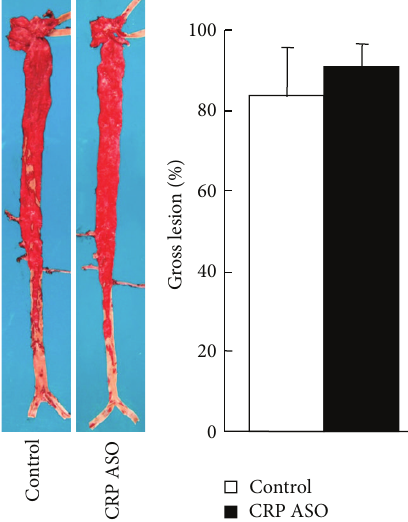
Figure 8: Analysis of aortic atherosclerosis. Representative pho- tographs of pinned-out aortic trees stained with Sudan IV from CRP ASO-treated and control rabbits are shown (left), and aortic atherosclerotic lesions (defined by sudanophilic area) on the surface were quantified with an image analysis system (right). Data are combined from male and female rabbits and expressed as the mean ± SD. 𝑛 = 10 for each